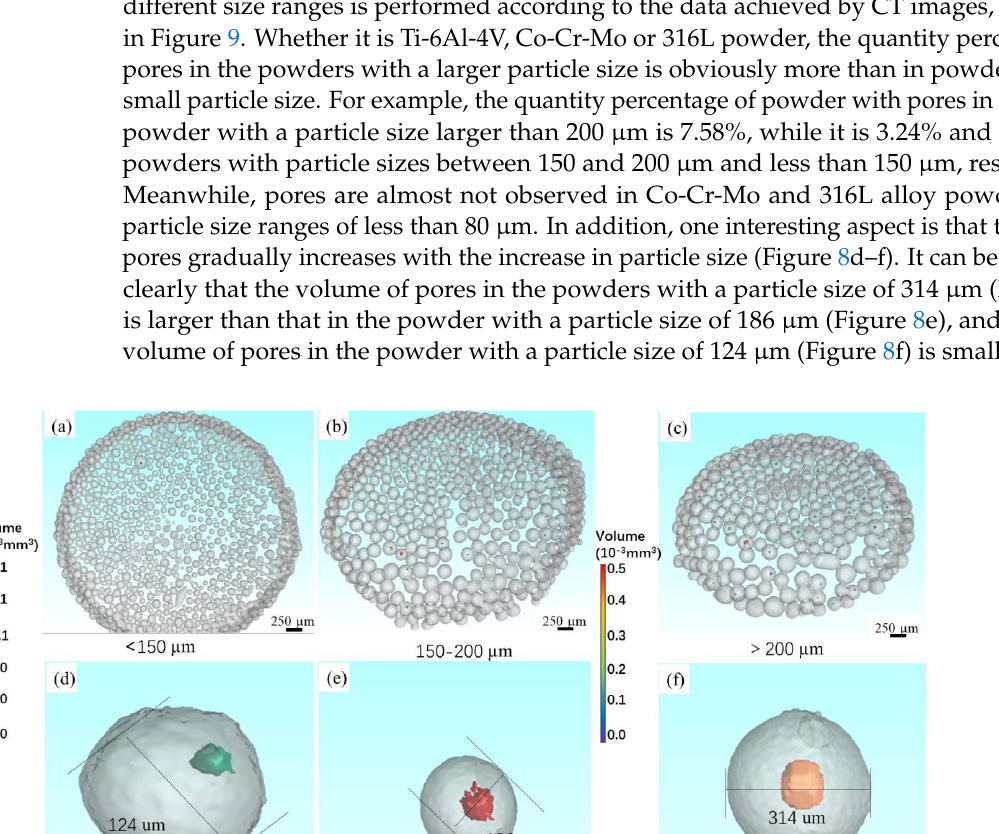
Figure 9. Quantity percentage of powder with pores in PREP powders as a function of particle size range and rotation speed. ( a ) Ti-6Al-4V, ( b ) Co-Cr-Mo, ( c ) 316L. 4. Discussion 4.1. Effect of Particle Size on Pore Characteristics During the atomization of PREP, the formation of pores in the powder is mainly due to the following reasons. First, the difference from the GA method is that the spheroidi- zation and solidification process of PREP droplets does not occur simultaneously. The molten metallic droplets are thrown from the end surface of electrode bar, and then so-